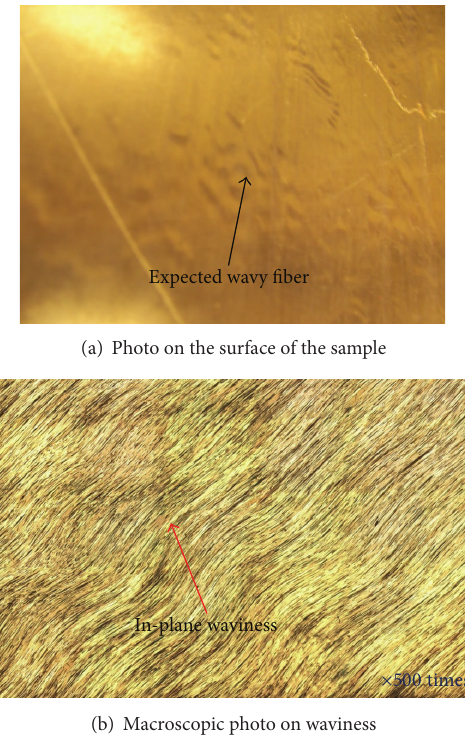
Figure 14: Photo of sample surface and microscopic photo of in- plane fiber waviness in CFRP